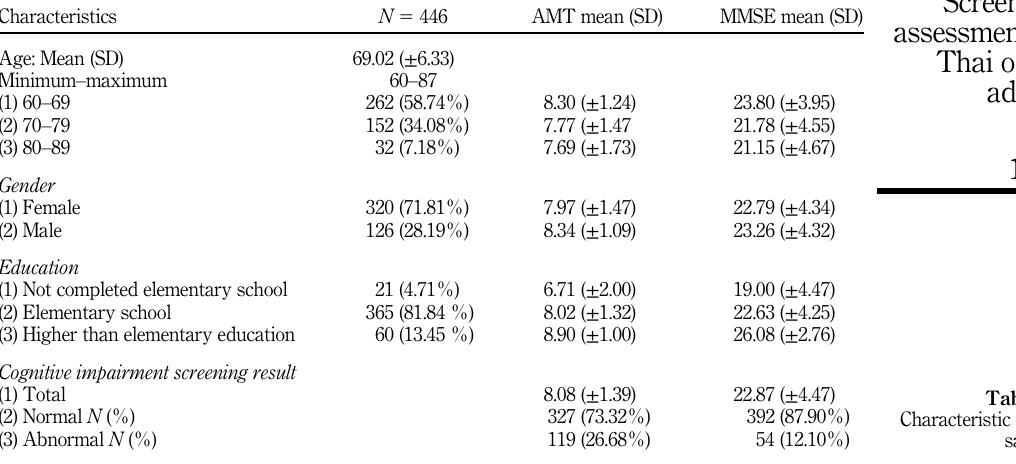
Table 1. Characteristic of